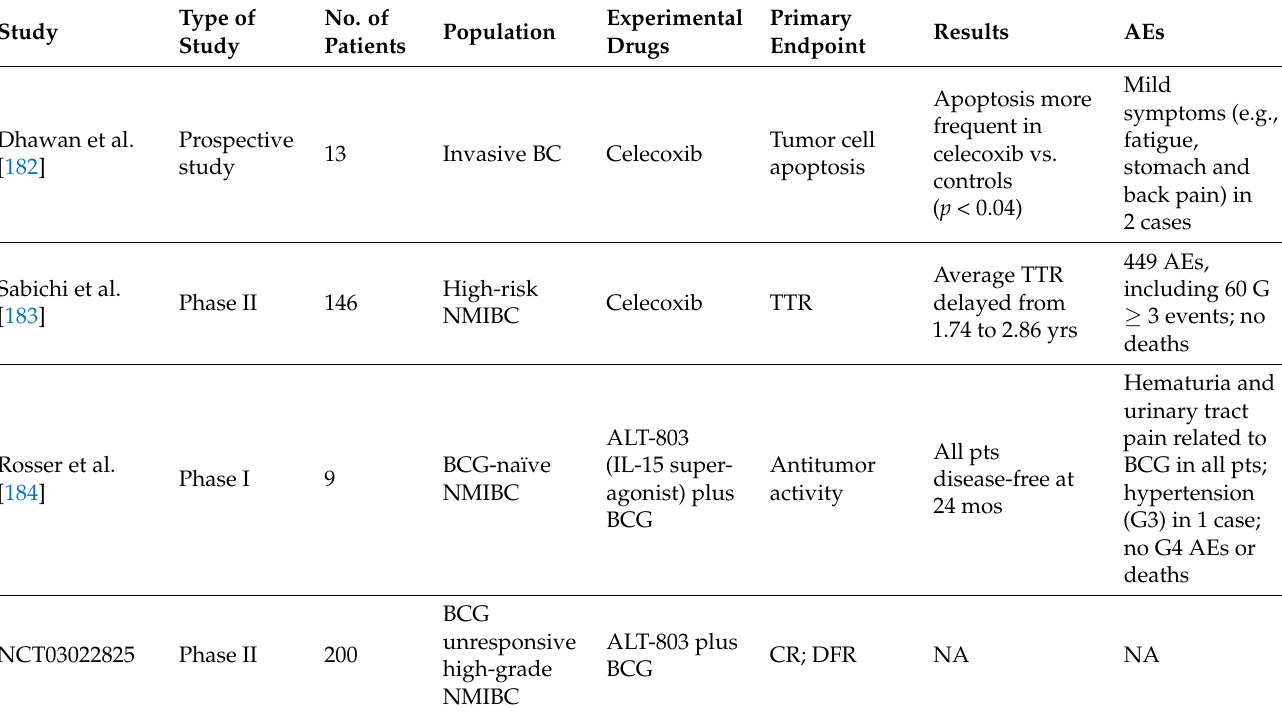
Table 1. Studies evaluating inflammation as a therapeutic target in genitourinary